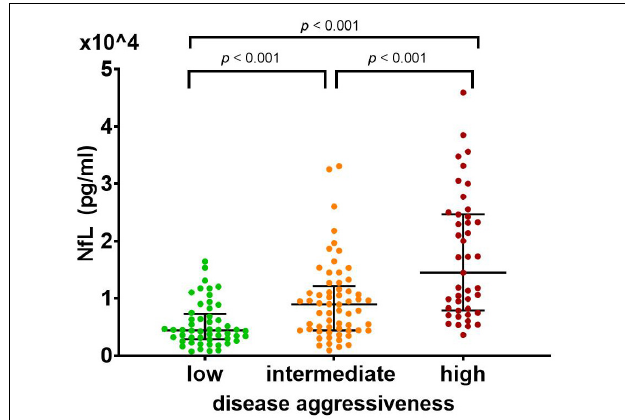
FIGURE 3 | CSF NfL differs significantly between patients with (a) high (0 ≤ D50 < 20, in red), (b) intermediate (20 ≤ D50 < 40, in orange), and (c) low (40 ≤ D50, in green) disease aggressiveness. This effect remained significant after controlling for clinical phenotype, presence of frontotemporal dementia, age, gender, disease phase, and laboratory of measurement in an ANCOVA ( p < 0.001). Post hoc pairwise comparisons of the estimated marginal means confirmed an increase of NfL levels with increasing disease aggressiveness (low: 4,477.13, intermediate: 7,194.49, high: 14,092.89; p < 0.001 for all pairwise comparisons). Bars indicate median and interquartile range. ANCOVA, analysis of covariance; NfL, neurofilament light chain.